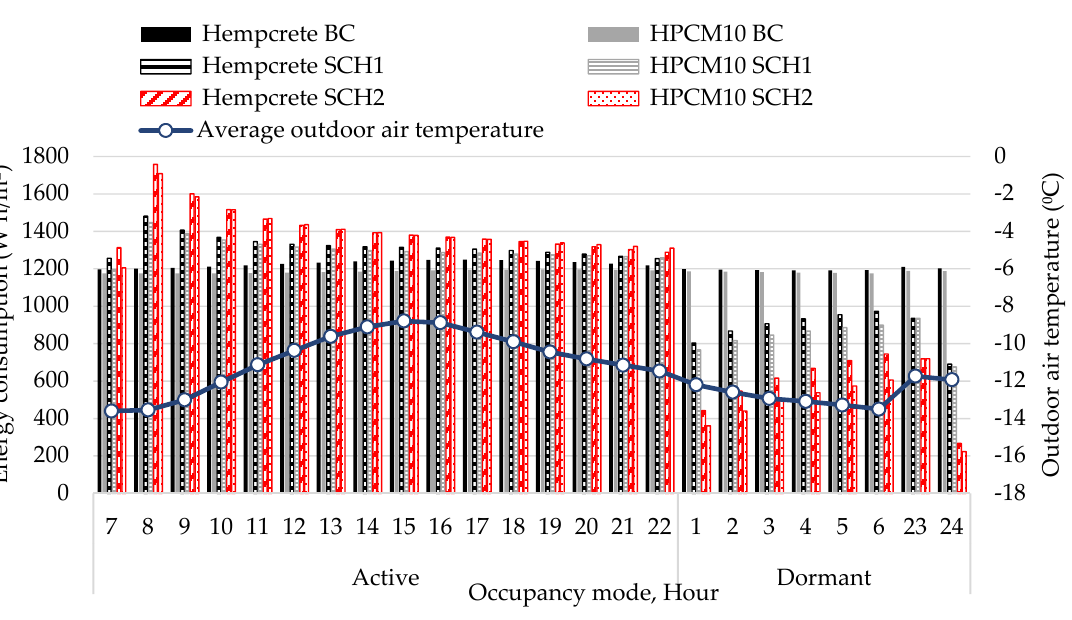
Figure 9. Average hourly heating energy consumption under BC, SCH1, and SCH2. Figure 10 illustrates the average interior surface temperatures of hempcrete and HPCM10 walls under SCH1 and SCH2 from November to March to provide additional insight into the performance of the latent heat storage. We can observe that the HPCM10 wall type maintained higher interior surface temperatures than hempcrete assembly, par- ticularly under SCH2 during dormant hours. For example, HPCM10 achieved between 0.01 and 0.18 °C higher inside wall surface temperatures than hempcrete under SCH1. This temperature difference between HPCM10 and hempcrete walls was higher under SCH2, ranging from 0.08 to 0.34 °C.